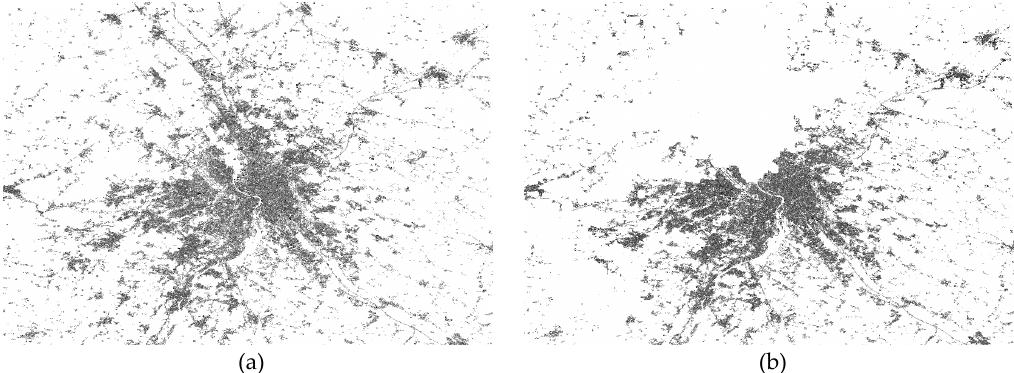
Figure 3. ( a ) The angle value pair from 2017-07 to 2018-07 compared to ( b ) the angle value pair from 2017-09 to 2018-09 for Toulouse shown in grey. Darker shades show higher angle and length pair values. Figure 3b is affected by clouds and does not provide information in some regions. Hence, a construction site cannot be detected until valid imagery is available and thus the date of detection will deviate from the original starting date of the